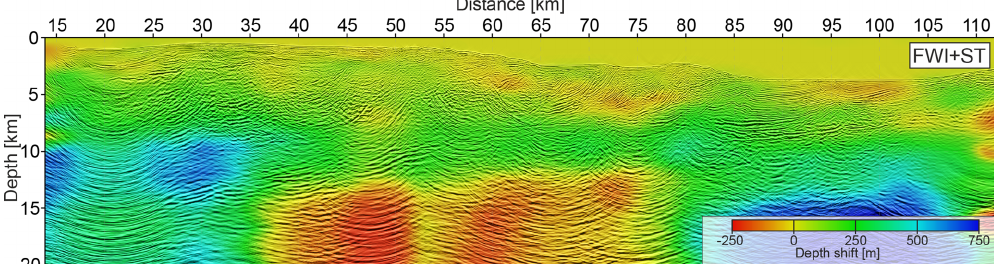
Figure 10. PSDM section inferred from the FWI+ST velocity model overlaid on the estimated depth shifts. Positive and negative values correspond to upshifts and downshifts introduced in the PSDM section by FWI+ST velocities relative to the FWI velocities, respectively. Note the nonsymmetric color